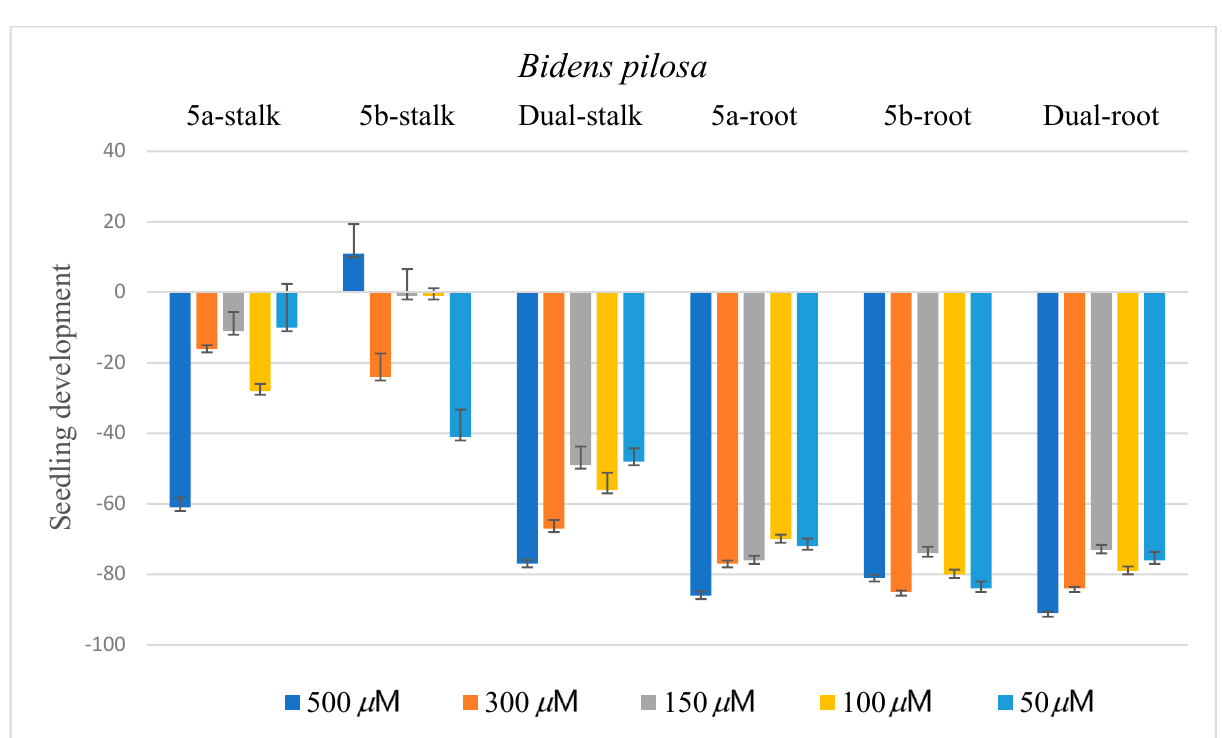
Figure 7. Development of Bidens pilosa ( Dicotyledonae ) seeds in relation to the positive control Dual. The optimized structures of the most stable conformers of epoxides 5a and 5b are shown in Figure 8. Epoxide 5b has a folded structure, while 5a has a flatter structure. Despite the diastereomeric relationship, 5a and 5b have completely different conforma- tions. That is, 5b looks like a folded envelope, while 5a is more like an open envelope. Considering that 5a and 5b are diastereomers, the difference in the biological activity of these compounds may be associated with their shape in space, which differentiates them in the biological target.